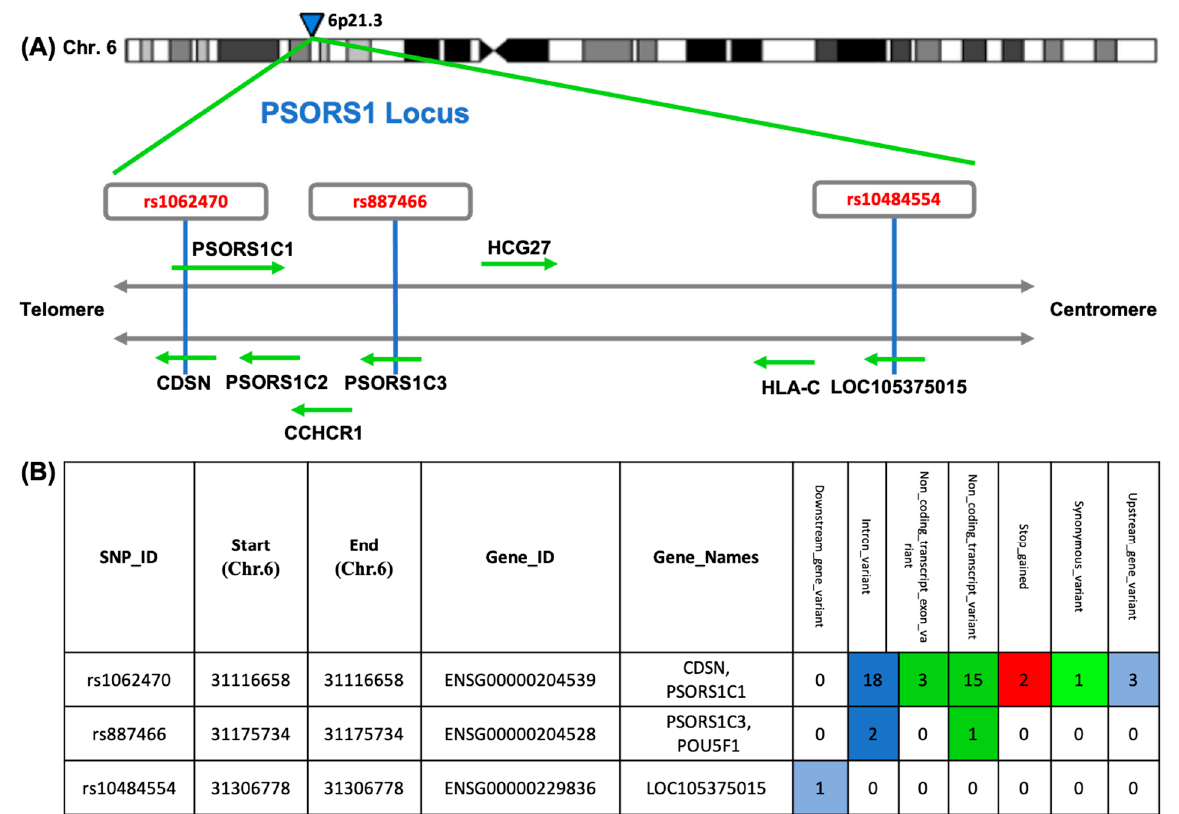
Figure 1. Single nucleotide polymorphisms (SNPs) included in the study. ( A ) Localization of the PSORS1 locus on human chromosome 6. ( B ) List of SNPs in the study to their gene names (official and Ensembl) with chromosomal coordinates and predicted variant effects. The variant effects are described with a color-coded set of variant consequences terms, defined by the sequence ontology and ordered by severity. The SNPs under study have 7 categories which are: downstream gene var- iant, intron variant, non-coding transcript exon variant, non-coding transcript variant, stop gained, synonymous variant, and upstream gene variant. (This diagram was constructed based on Ensembl